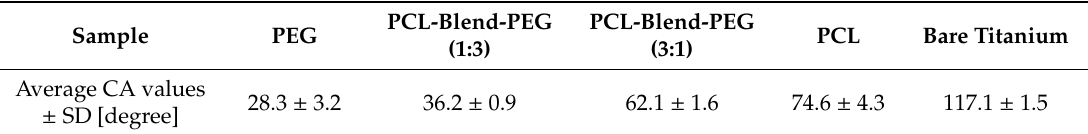
Table 1. Contact angle values for simple and blend coatings deposited by DC technique. (The data are given as mean ±